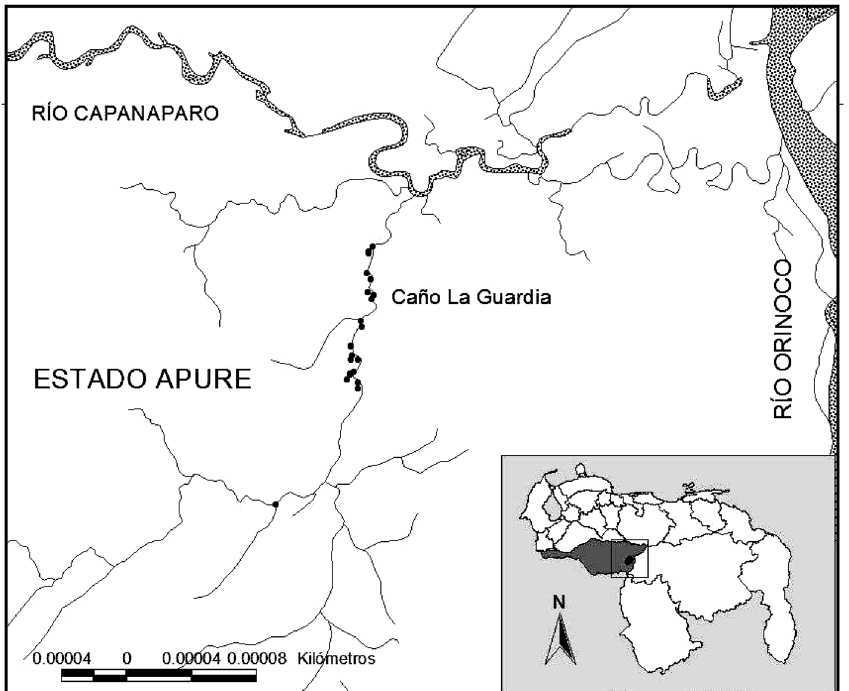
Fig. 1. Location of Caño La Guardia in the southwestern Apure State, Venezuela (Sampling sites are shown by black